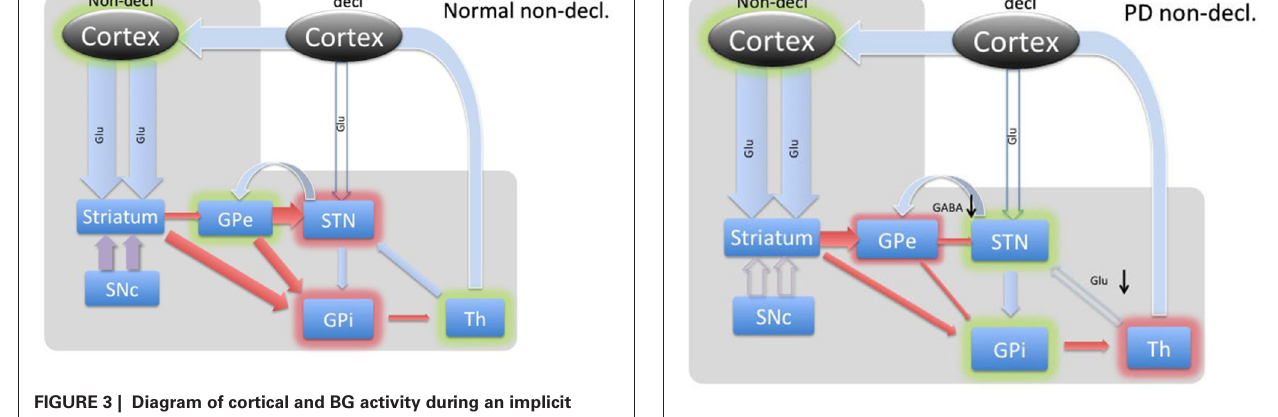
FIGURE 4 | Diagram of cortical and BG activity during an implicit memory task in a Parkinson’s patient. The expected changes in STN are the decreased concentration of GABA and the increased concentration of glutamate. The meanings of arrows and shadows are the same as in Figure 3